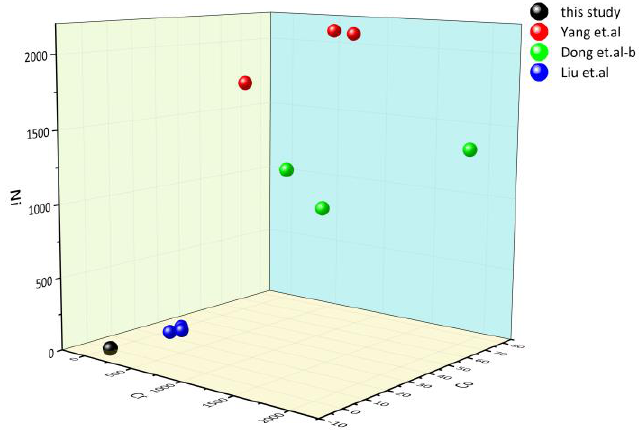
Figure 8. The 3D scatter plot of Cr, Co, and Ni